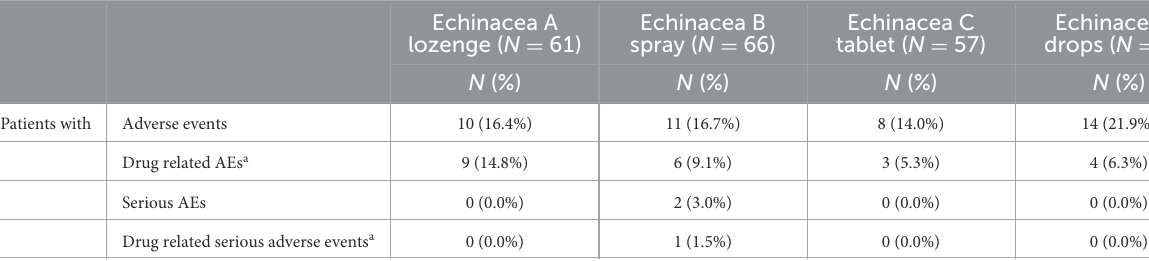
TABLE 4 Adverse